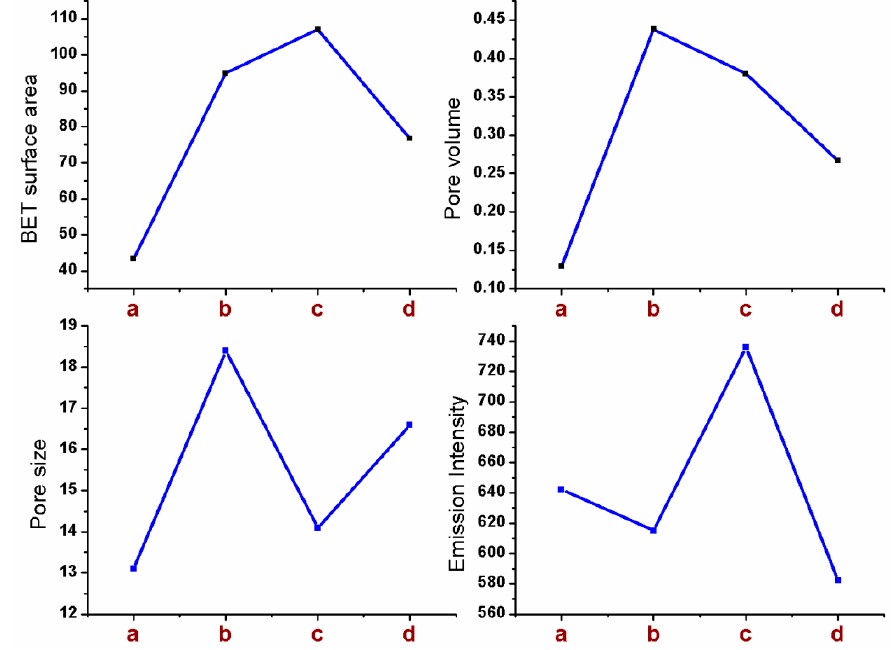
Figure 6. A perspective view of effect of amino acids on BET surface area, pore volume, pore size and emission intensity (( a ) Sm-FAp/Glutamic acid; ( b ) Sm-FAp/Aspartic acid; ( c ) Sm-FAp/Glycine; ( d ) Sm-FAp/Histidine).